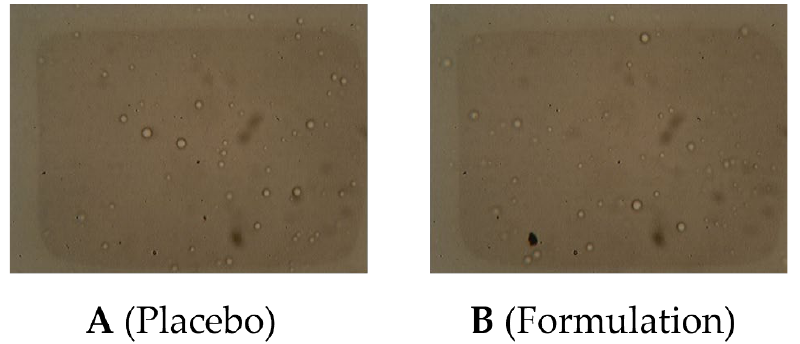
Figure 4. Globule shape of freshly prepared base ( A ) and test ( B ).